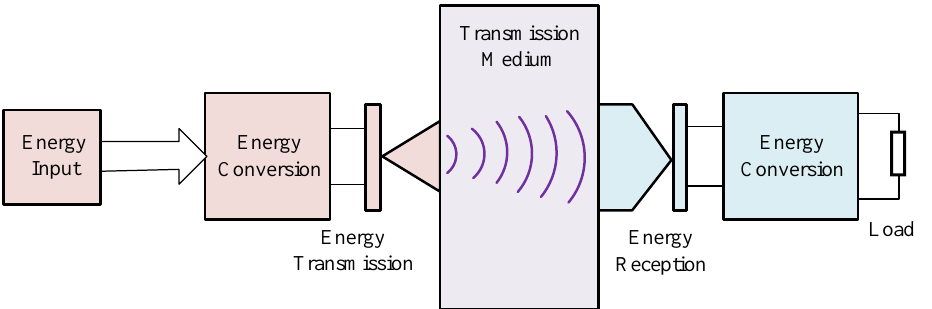
Figure 1. Working principles of wireless power transfer technology.